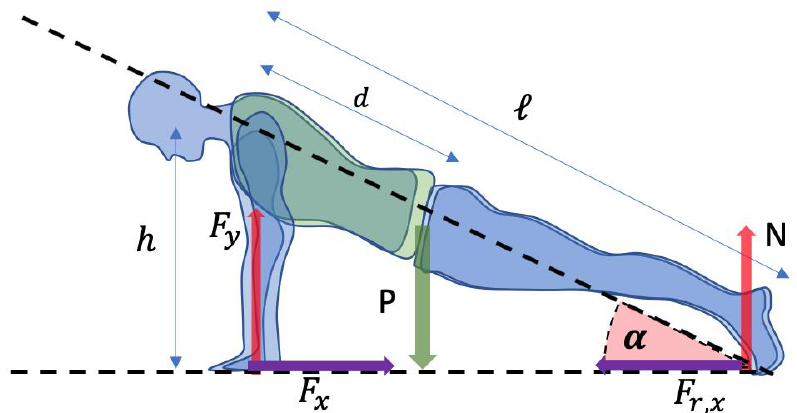
Figure 6. Force system in the push up position.